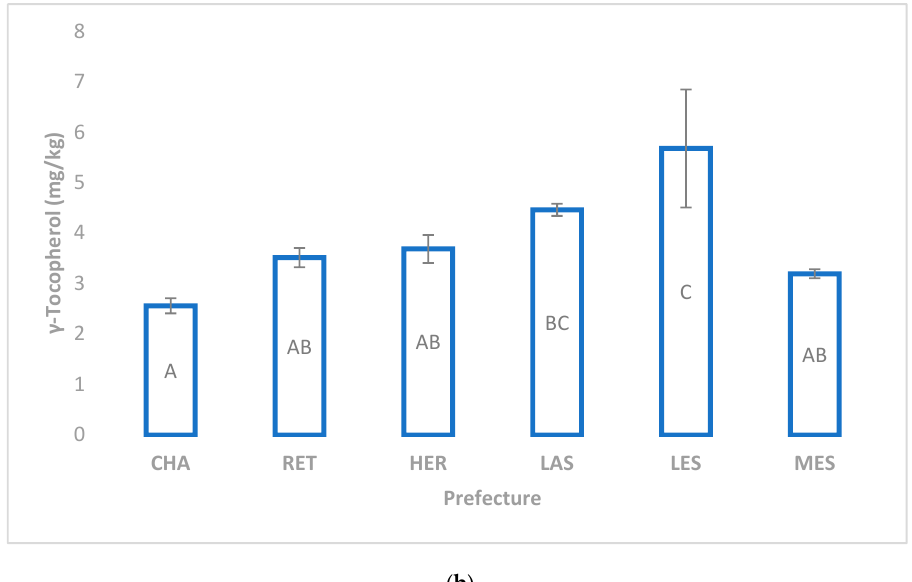
Figure 2. Content (mean ± standard error) of: ( a ) α -tocopherol and ( b ) γ -tocopherol in EVOOs from the Koroneiki cultivar produced in various regions of Greece. Different letters indicate significant difference (Tukey’s HSD test, p ≤ 0.05) between the prefectures. CHA: Chania; HER: Heraklion; LAS: